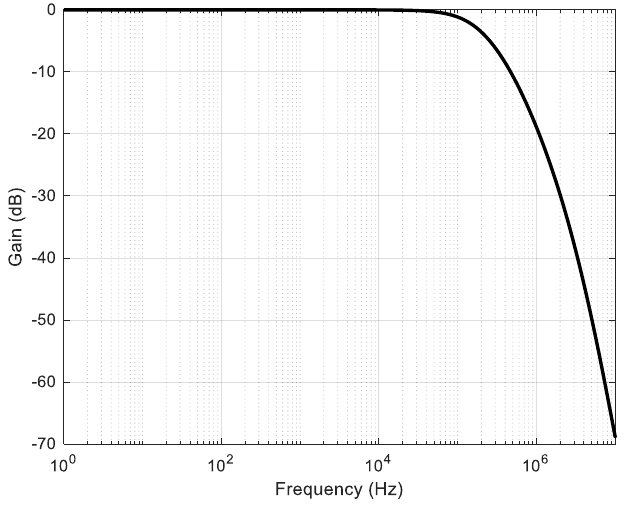
Figure 6. Closed-loop frequency response.